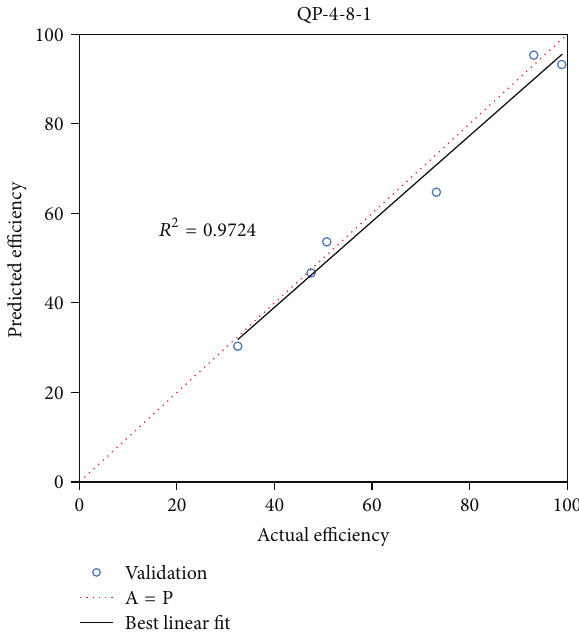
Figure 4: The validation test of the provisional model (QP-4-8-1) which consists of actual and predicted photodegradation efficiency as well as the best linear fit and 𝑅 -square.